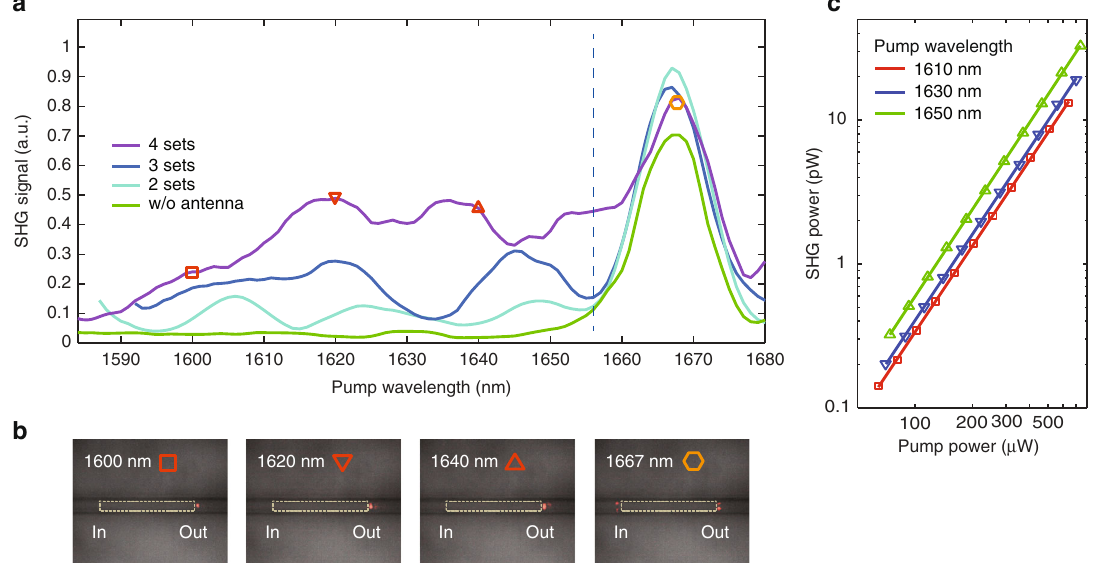
Fig. 4 Experimental results. a Measured SHG power at the output port of devices patterned with different number of phased antenna arrays, in comparison with that of a bare LiNbO 3 waveguide, showing broadband SHG enhancement (to the left of the dashed line). The narrow SHG peak at a pump wavelength of 1667 nm (to the right of the dashed line), which exists in all tested devices including bare LiNbO 3 waveguides, is the result of an accidental phase- matching between the pump, TE 00 ( ω ), and the seventh-order TE waveguide mode at the SH frequency, TE 06 (2 ω ). b Top-view camera images showing the scattered SH light from a device patterned with a gradient metasurface consisting of four phased antenna arrays (indicated by the white dashed frames). At pump wavelengths of 1600, 1620, and 1640 nm, SH signal (red spots) is only observed at the output end of the gradient metasurface, which indicates that the SH signal is generated within the metasurface-covered section of the device. In contrast, at the accidental phase-matching peak wavelength of 1667 nm, scattered SH light appears at both the input and output ends, which indicates that the SH signal has already been generated by the phase-matching process before it enters the metasurface section. c Input – output power relations for the device showing quadratic power dependence between the pump and the SH signal at three different pump